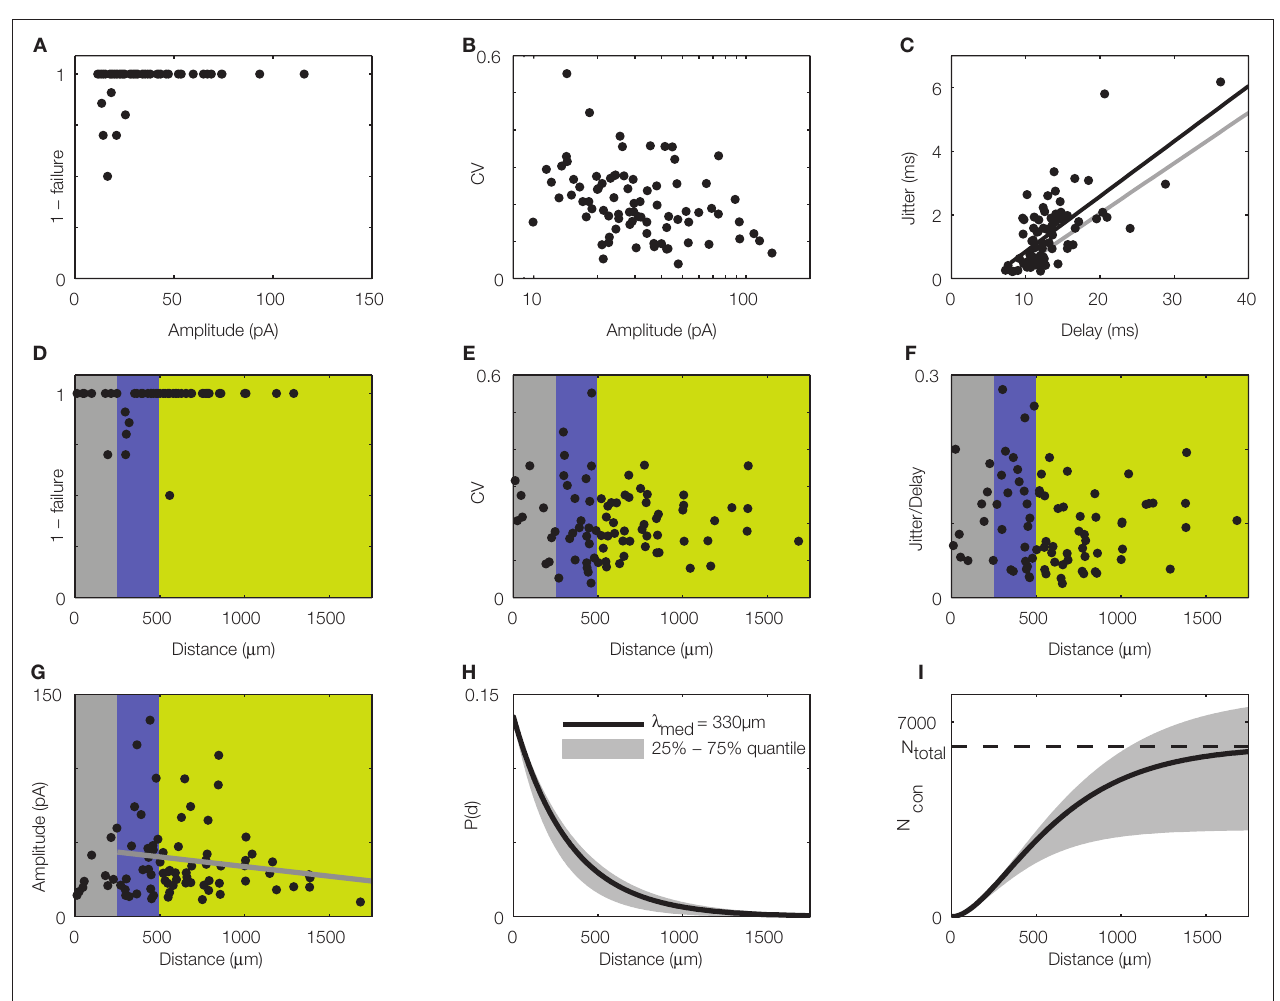
was 100 μm, and for each horizontal distance, we collected the number of sites, stimulation of which resulted in a postsynaptic EPSC. The ratio of this number relative to the total number of stimulations at the corresponding distance was taken as the estimated connection probability at that distance ( n = 674 EPSCs in total). When stimulation sites were close to the soma or apical dendrite, EPSCs were often masked by large currents from uncaged glutamate impinging directly on the postsynaptic cell (direct responses). Probed distances where more than 20% of stimulated sites showed such direct responses were excluded from the analysis. Since it remains unknown how many neurons we stimulated at each target site and it was, thus, only possible to extract relative connection probabilities, we defined P = 0.1 at a 100 distance of 100 μm, as suggested by paired recording studies (see Table 1 ). Our model of exponential decay is, thus, constrained as P ( d ) = P ⋅ exp( − d / λ ). 0 Single fits were performed for each experiment, and length constants λ were extracted. The panel shows an exponential decay with a length constant equal to the median of all extracted λ -values (black trace), upper and lower shaded regions mark the 75 and 25% quantile, respectively. (i) Accumulated number of connected cells as a function of lateral distance d from the soma: we estimated the number of connected neurons within a cylindric volume with radius d as N d f h P s sds d , with ρ = 60,000/mm 3 (black trace) con 0 πρ defining the cell density per cortex volume, f = 0.85 representing the relative E fraction of excitatory connections (Braitenberg and Schüz, 1998), and h = 1.3 mm defining the thickness of the gray matter. The estimated total ~ 6,100 with λ of 330 μm number of presynaptic cells then amounts to N total ∞ (black trace; shaded regions mark total cell numbers for respective λ taken from the shaded region in H